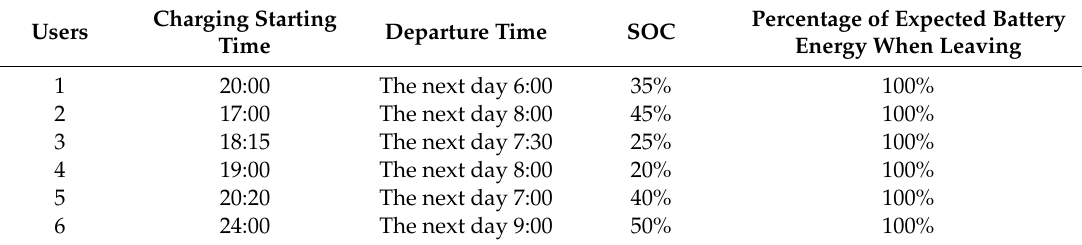
Table 1. User charge vehicle demand information. SOC: state of charge.